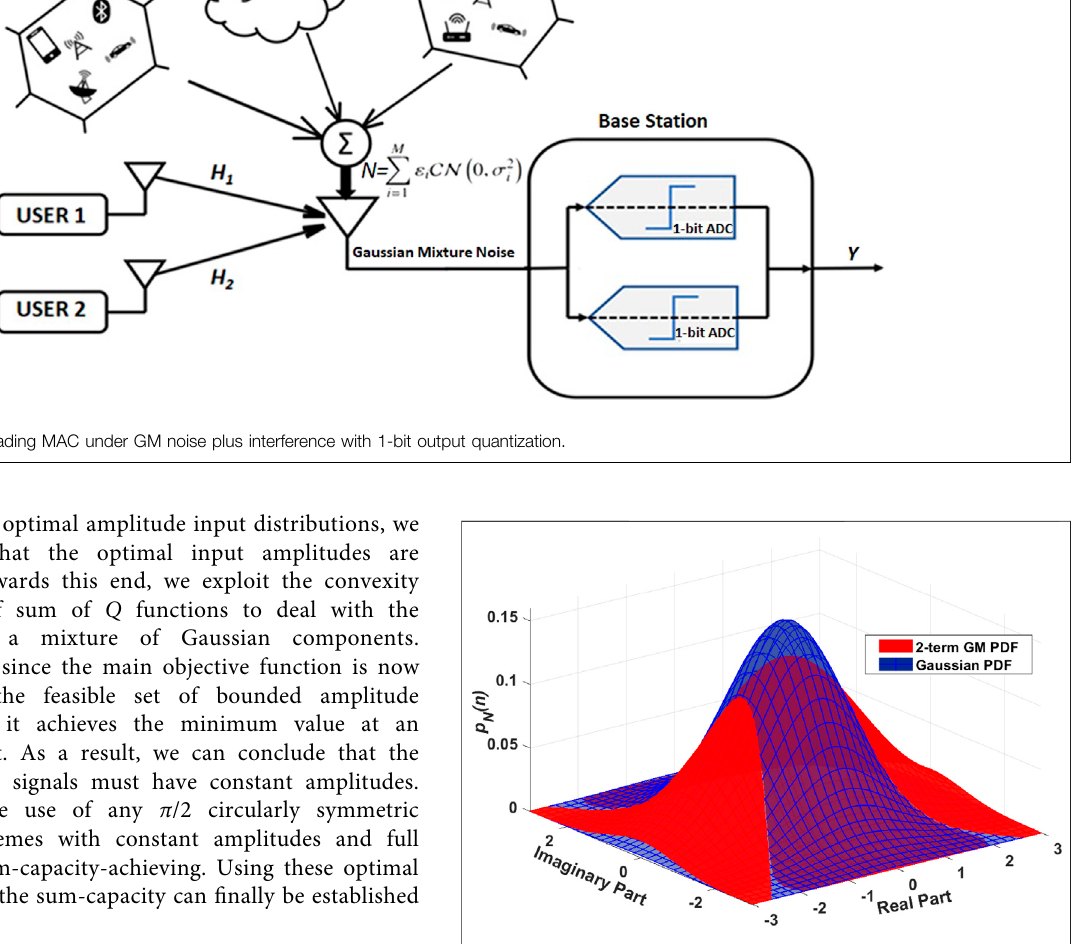
FIGURE 2 | The Gaussian and 2-component GM